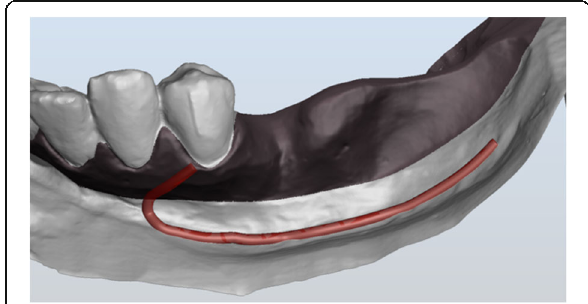
Fig. 1 Schematic drawing of the poncho flap